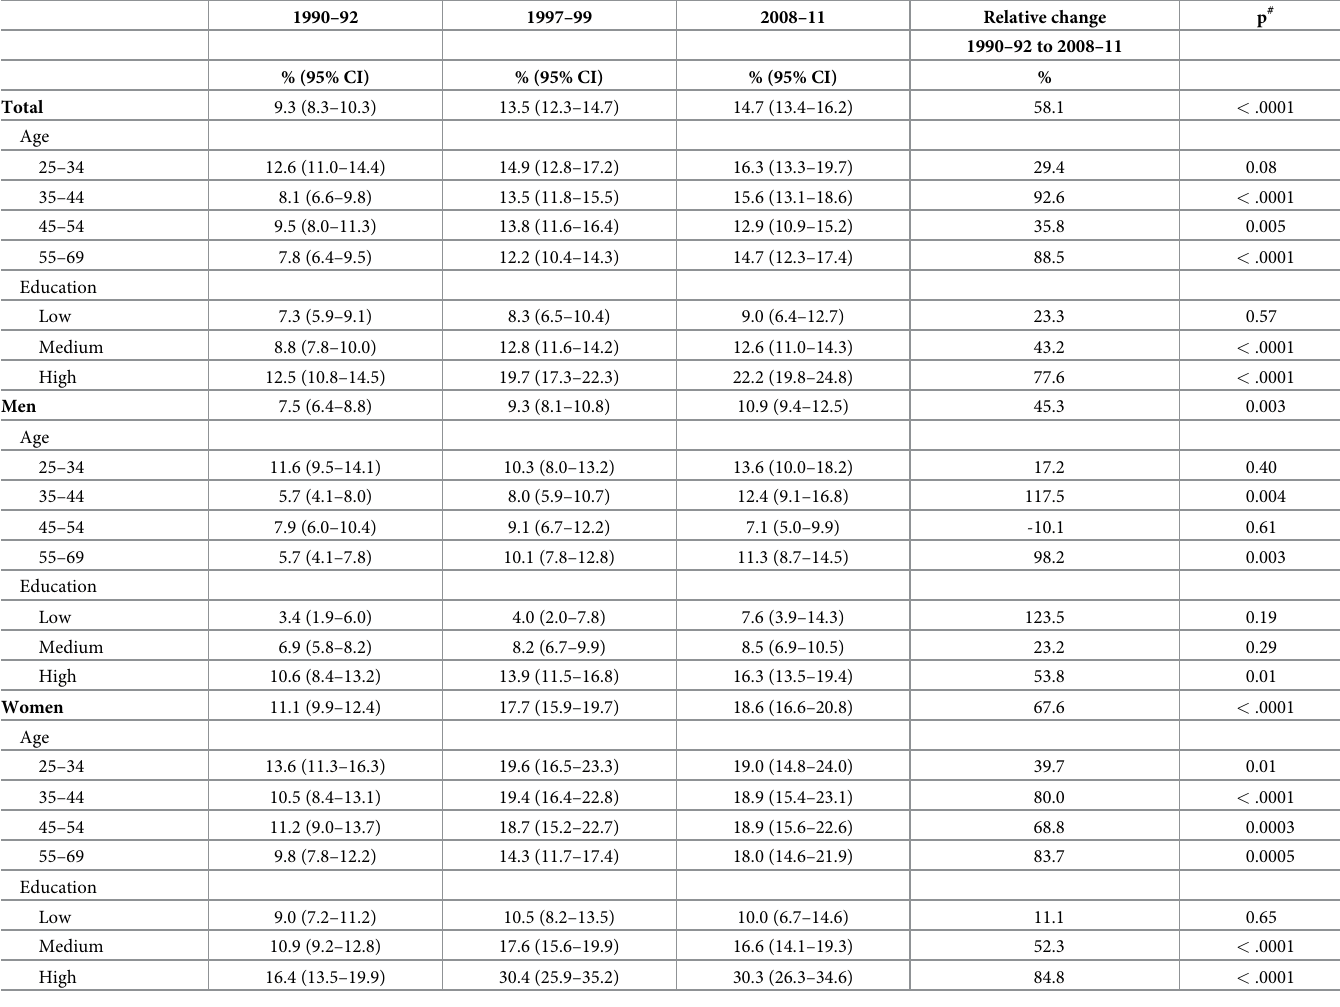
Table 3. Proportions (%) of adhering to a healthy lifestyle 1 among men and women according to sex, age group and